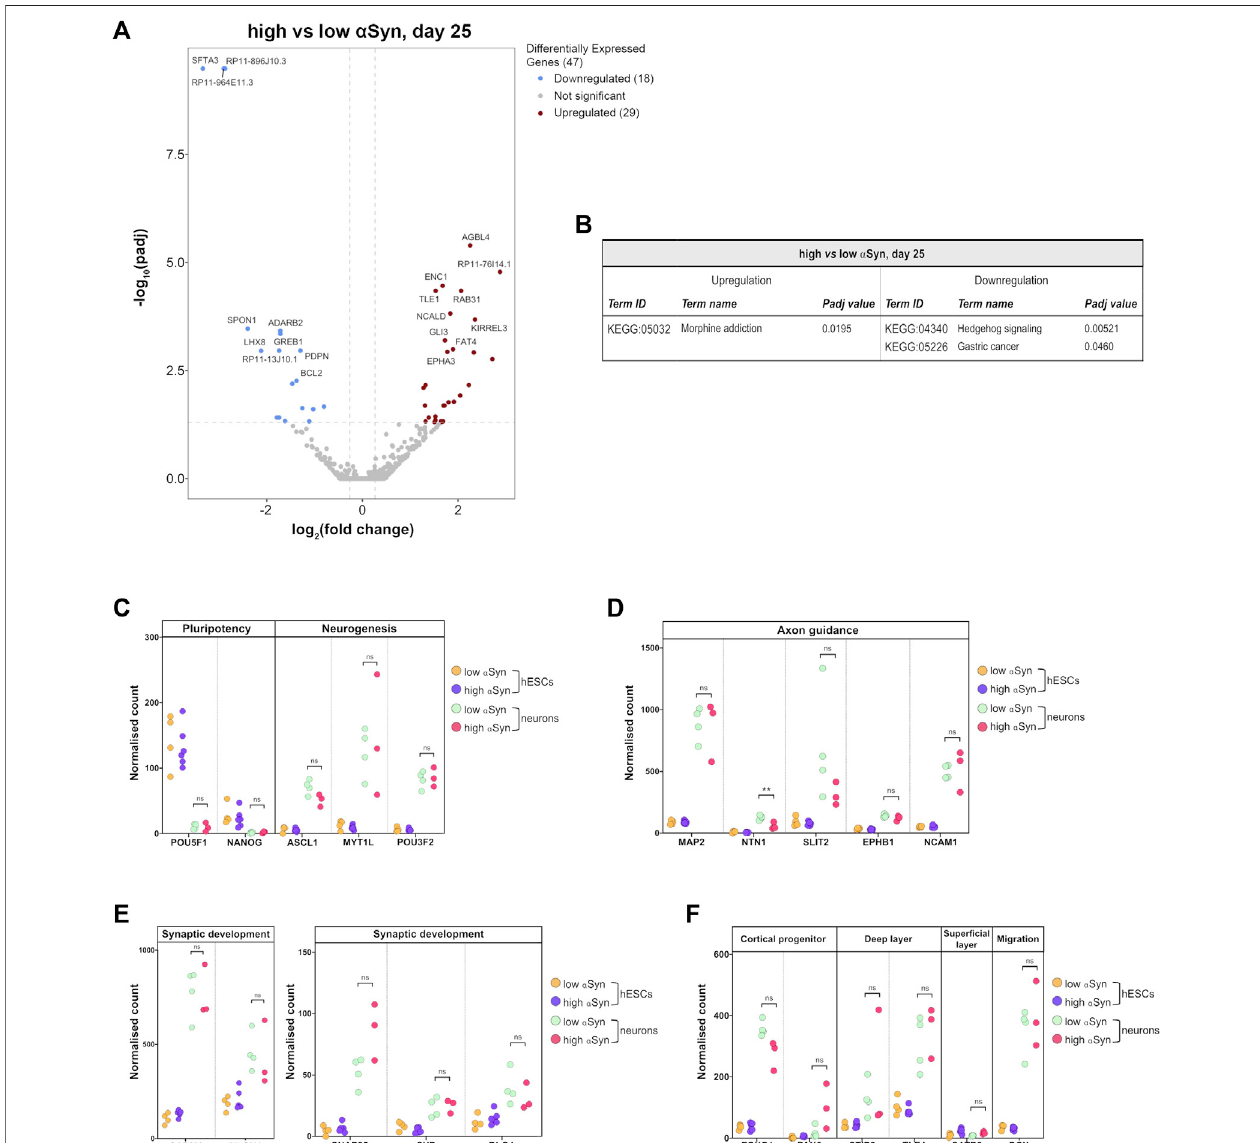
FIGURE 8 | RNA-seq analysis reveals that α Syn overexpression does not have a signi fi cant impact on cortical marker gene expression. (A) Volcano plot showing distribution of differentially expressed genes between high α Syn and low α Syn day 25 cortical neurons (B) Table showing all upregulated and downregulated KEGG terms for this comparison. (C – F) Plots showing normalised single gene read counts across all four sample groups for (C) pluripotency and neurogenesis markers, (D) axon guidance genes, (E) synaptic development genes, and (F) cortical progenitor, deep layer, super fi cial layer, and migration genes. Statistical comparisons between cortical neurons were performed using the Welch ’ s t -test (** p < 0.01).